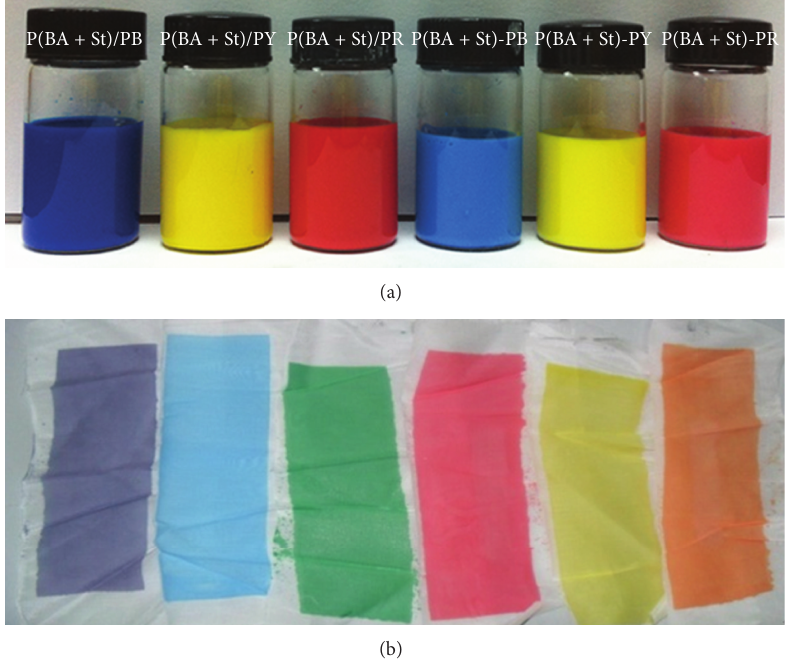
Figure 2: Photos of the polymer/pigment nanocomposite latexes and blended latexes with three primary color pigments (a) and the cotton fabrics pigment printed by nanocomposite latexes at different microcapsules ratio